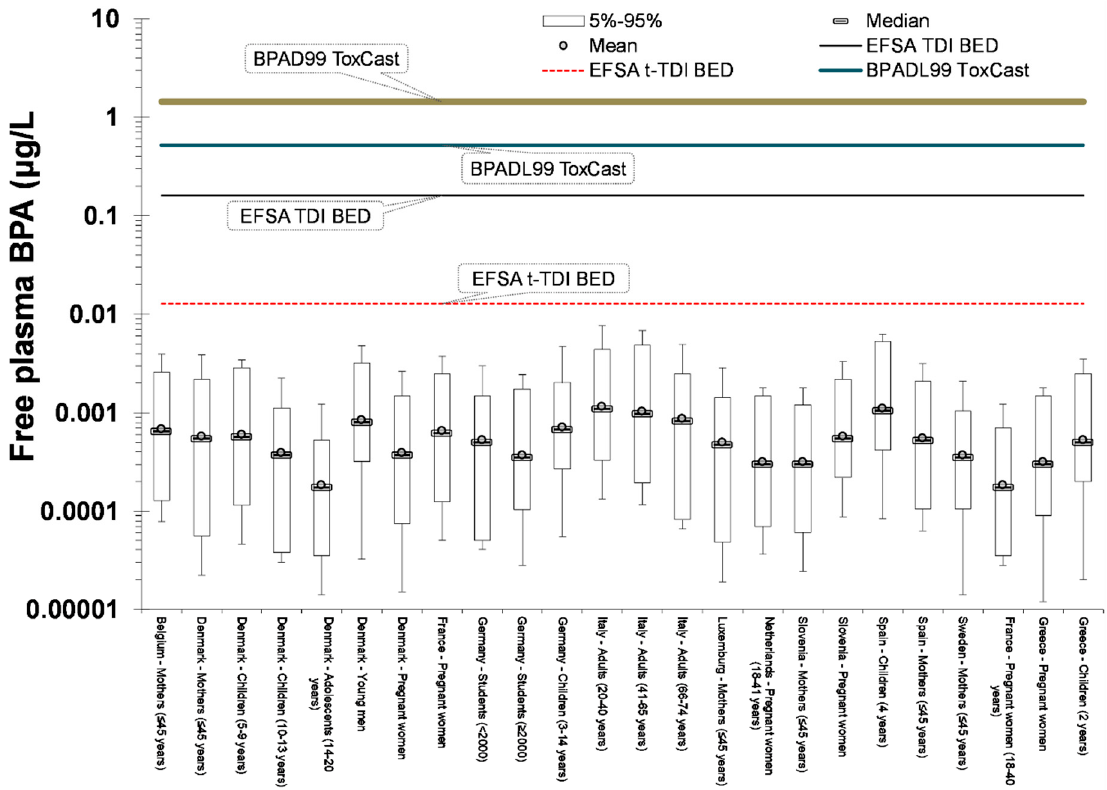
Figure 4. Free plasma BPA for the population included in the included HBM studies (refined internal exposure analysis).